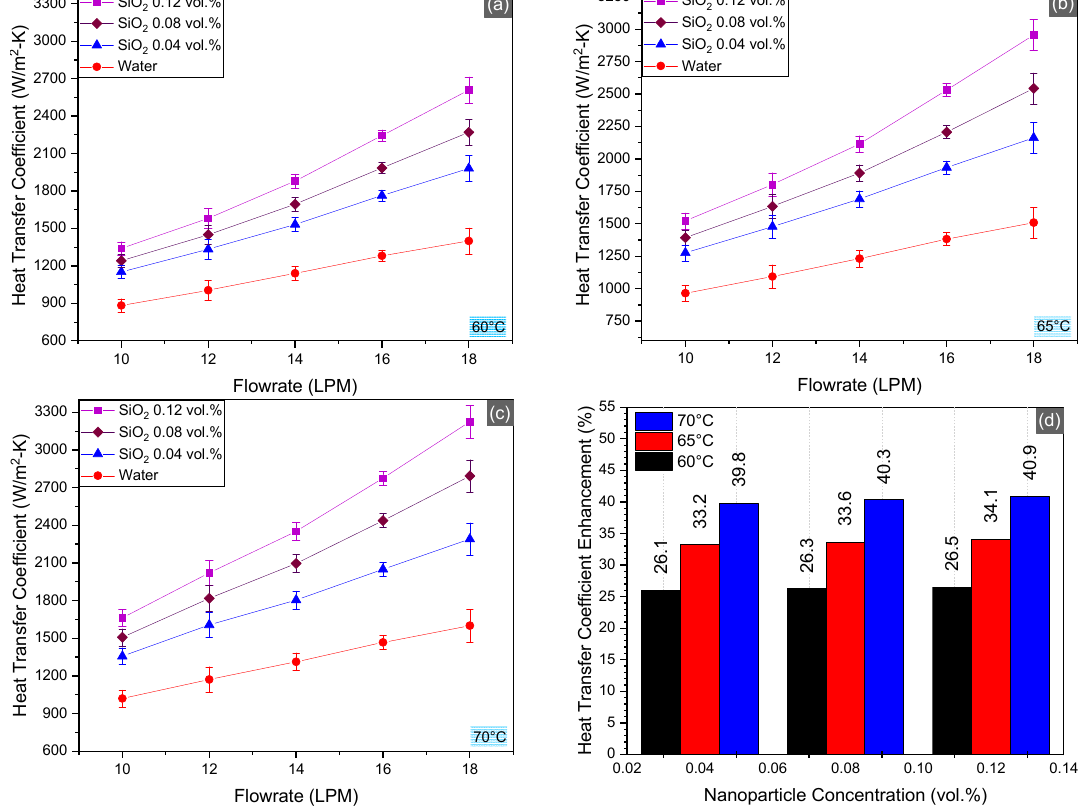
Figure 7. Convection heat transfer coefficient in the radiator at inlet temperatures 60–70 ℃ ( a – c ) and average enhancement in heat transfer coefficient for SiO 2 /water nanofluid as compared to the basefluid ( d ).